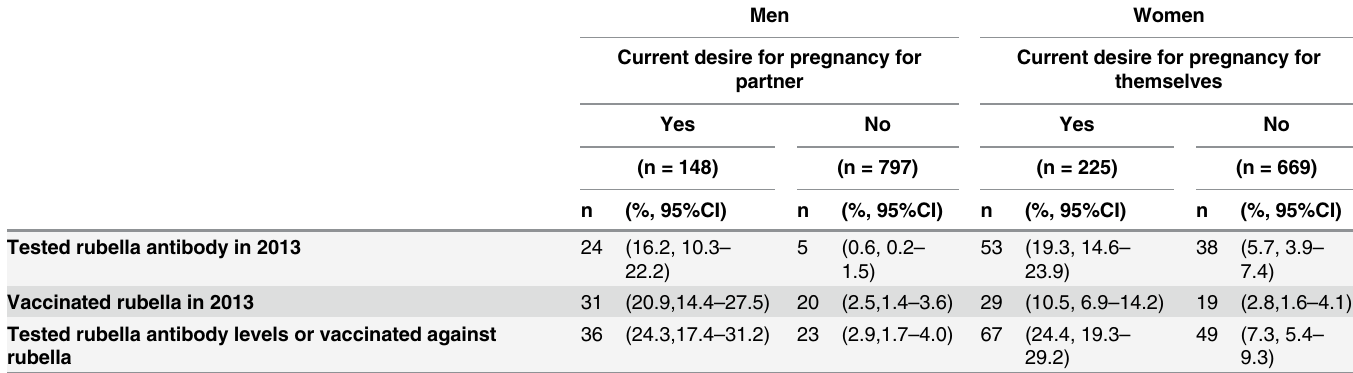
Table 2. Participants who had undergone antibody testing or had been vaccinated against rubella during the 2013 outbreak in Japan.